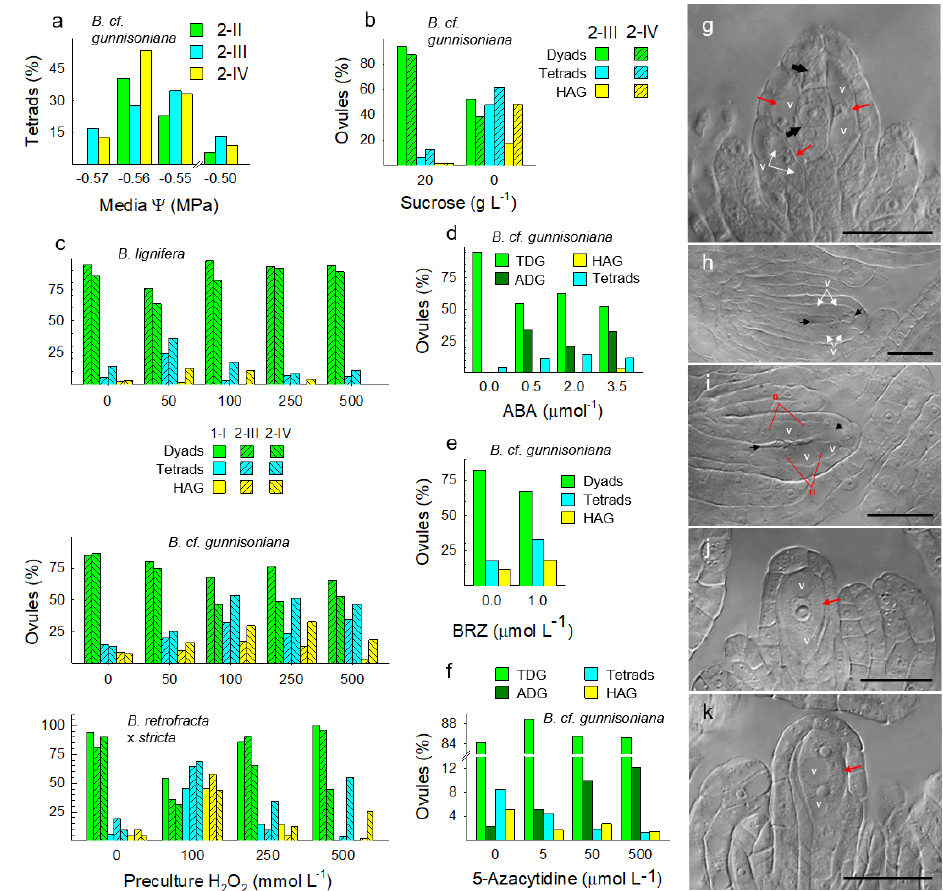
Figure 9. E ff ects of pharmacological treatments and pistil maturity on conversion from Taraxacum-type gametophyte formation (TDG) to (i) meiosis, (ii) Hieracium-type gametophyte formation (HAG), and (iii) Antennaria-type gametophyte formation (ADG): ( a ) drought (media water potential); ( b ) energy starvation; ( c ) reactive oxygen species stress (H 2 O 2 ); ( d ) abscisic acid (ABA); ( e ) brassinazole (BRZ, brassinosteroid synthesis inhibitor); ( f ) 5-azacytidine (DNA methylation inhibitor); ( g ) sucrose starved Boechera cf. gunnisoniana ovule with a Taraxacum-type diplosporous dyad (black arrows) and three 1 nucleate vacuolate HAGs (red arrows; v, vacuoles); ( h – i ) H 2 O 2 induced conversions from TDG formation to meiosis, but with all four megaspores degenerating (between black arrows), and from programmed cell death of nucellar cells to apospory (n, nuclei); ( j , k ) ABA induced conversions from TDGs to ADGs. Numbers of informative ovules per treatment (average, range): ( a ), 222, 103–289; ( b ), 81, 22-164; ( c ), Boechera lignifera (70, 29–168), B. cf. gunnisoniana (217, 78–465), Boechera retrofracta × stricta (77, 6–138); ( d ), 183, 160–201; ( e ), 102, 84–119; ( f ), 382, 178–487. Pooled chi-squares were significant ( p < 0.001). 1-I, late pre-MMC; 2-II, enlarging MMC; 2-III, mature MMC; 2-IV, meiosis; cytology bars, 20 µ